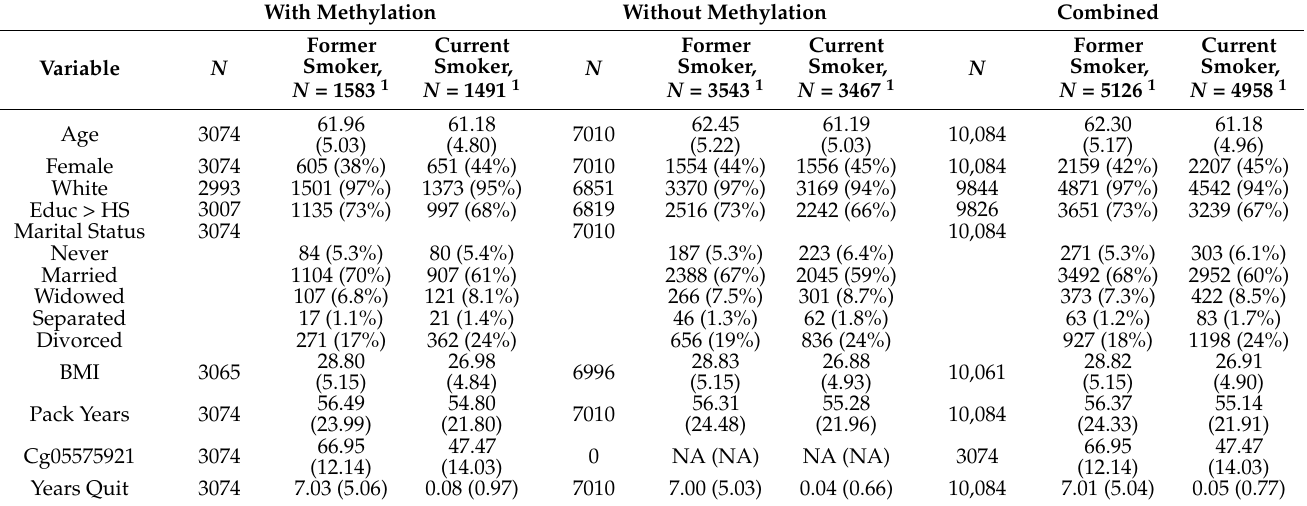
Table 1. Descriptive statistics of key variables for three groupings of the overall